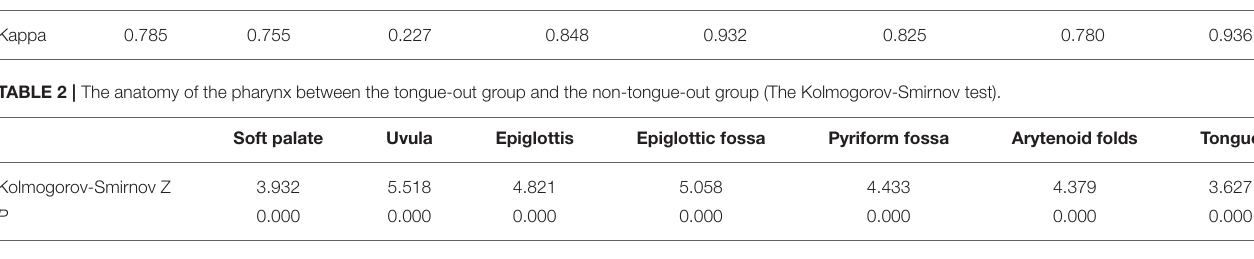
TABLE 3 | The scores of the anatomy of the pharynx between the tongue-out group and the non-tongue-out group (The Mann-Whitney U test).